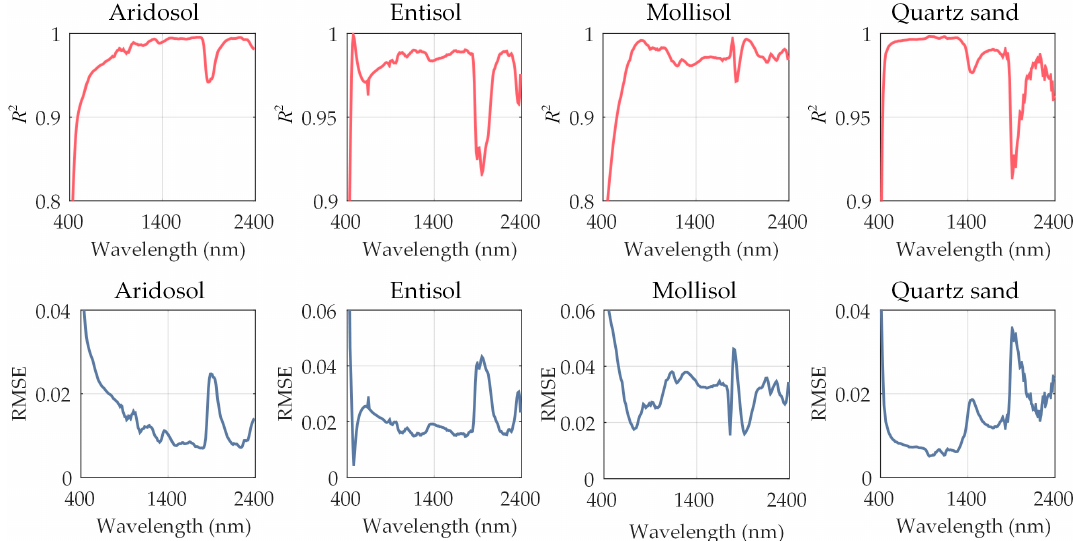
Figure 11. R 2 and RMSE at different wavelengths for four soils.